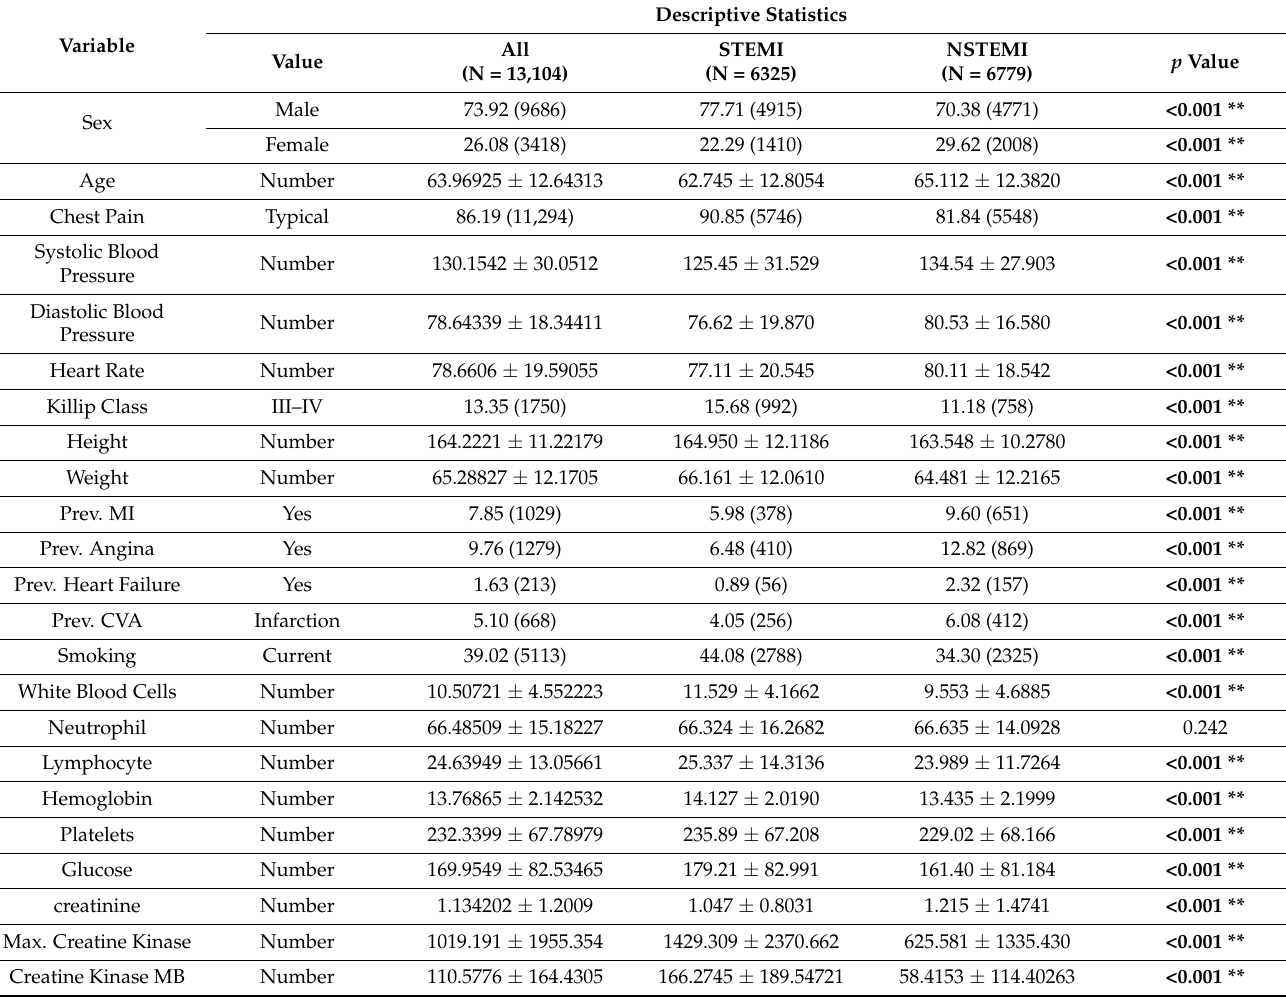
Table 2. Baseline characteristics of important features for all subjects (N =